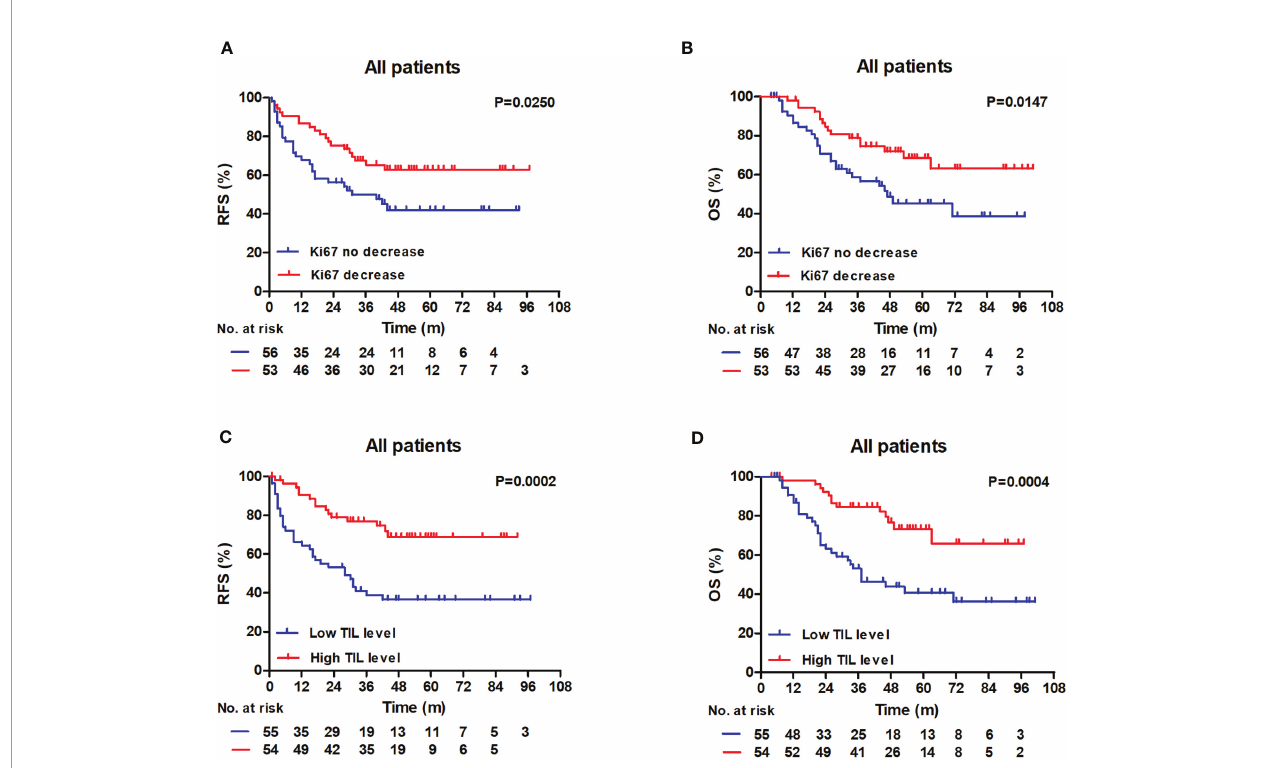
FIGURE 3 | RFS and OS outcomes in the whole patient cohort according to the TIL level and the Ki67 status. (A, B) Patients with decreased Ki67 status exhibited raised 3-year RFS and 3-year OS compared with patients without (RFS: 62.8% vs 47.7%, log-rank, P = 0.0250; OS: 78.9% vs 58.8%, log-rank, P = 0.0147). (C, D) Patients with low RD TIL levels exhibited reduced 3-year RFS and 3-year OS compared with patients with high RD TIL levels (RFS: 41.1% vs 68.8%, log-rank, P = 0.0002; OS: 53.1% vs 84.6%, log-rank, P = 0.0004). RFS, recurrence-free survival; OS, overall survival; TIL, tumor-in fi ltrating